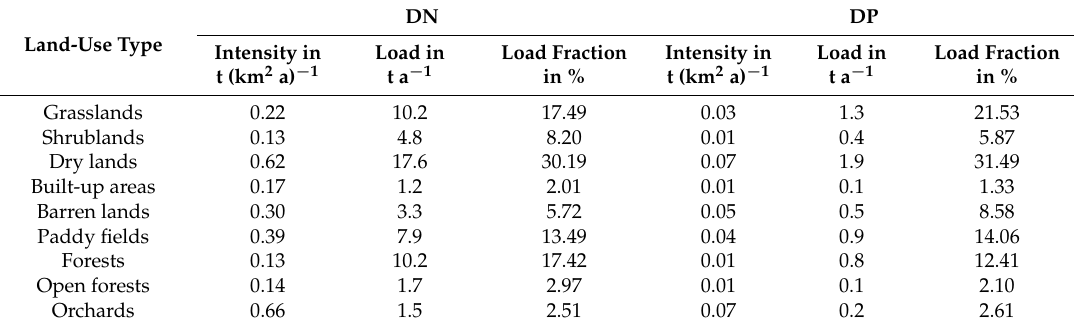
Table 3. DN and DP loads discharged into Lake Chenghai from the different land-use types.